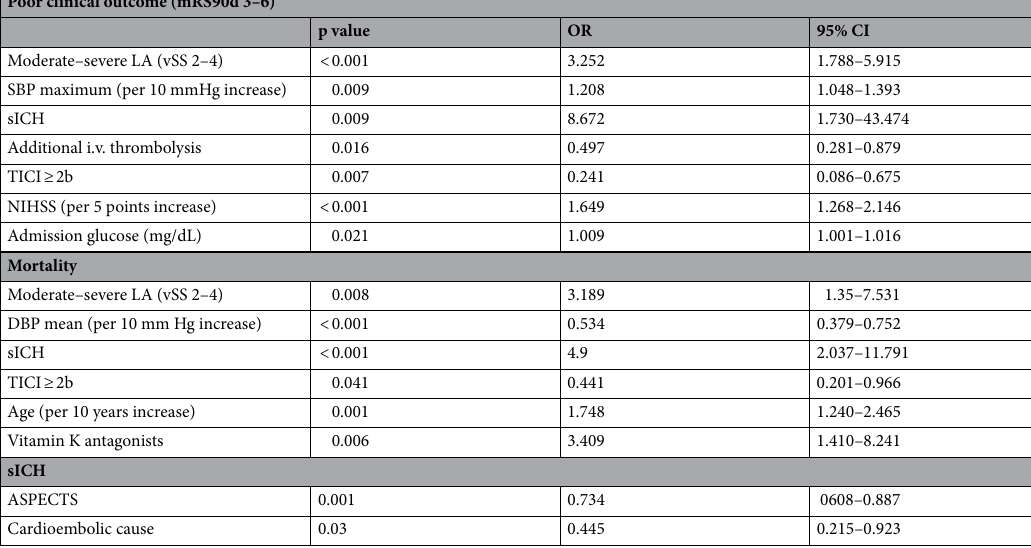
Table 2. Independent predictors of outcomes in multivariate logistic regression analysis. mRS90d modified Rankin Scale at 3 months, sICH symptomatic intracerebral hemorrhage, LA Leukoaraiosis, vSS van Swieten